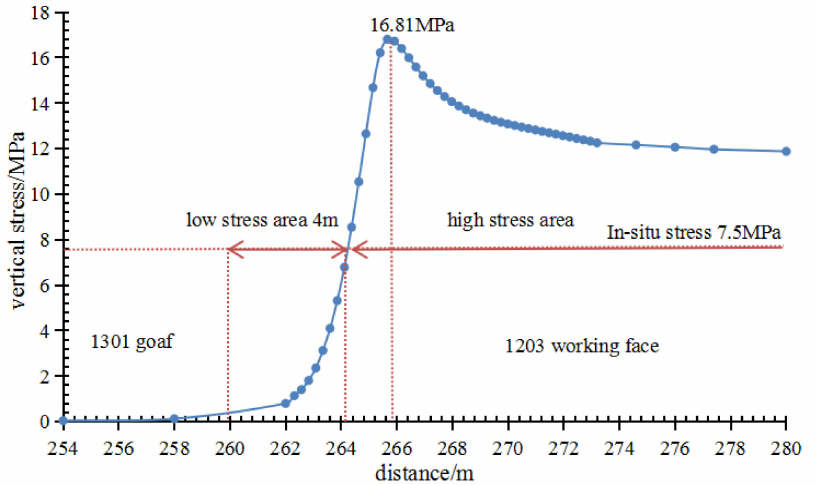
Figure 7. Local curve of the lateral surrounding rock vertical stress after mining the 1301 working